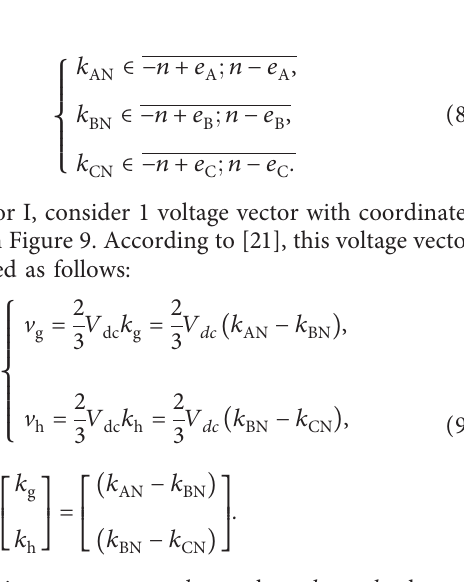
Figure 9: Voltage vector v on sector